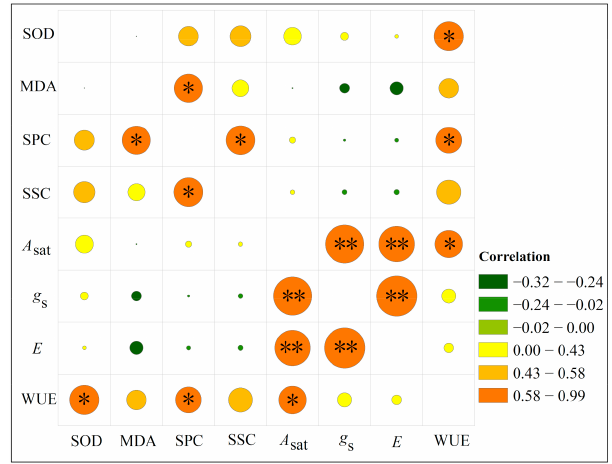
Figure 6. Correlation analysis of various physiological indicators of Pinus massoniana seedlings under drought stress. *, significantly correlated at the 0.05 level (bilateral); **, significantly correlated at the 0.01 level (bilateral). Under drought stress, WUE was significantly positively correlated with A sat , SOD activity, and SPC ( p < 0.05). SPC was significantly positively correlated with MDA and SSC ( p < 0.05), and A sat had a very significant positive correlation with both g s and E ( p <